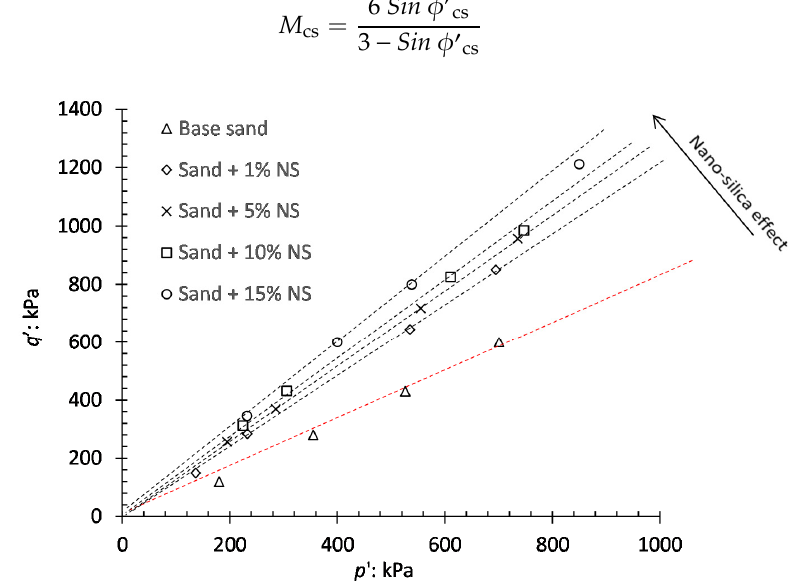
Figure 12. Critical states in q (cid:48) − p (cid:48) plane for base and NS-treated sands. Table 6. Effect of NS on critical state parameters.